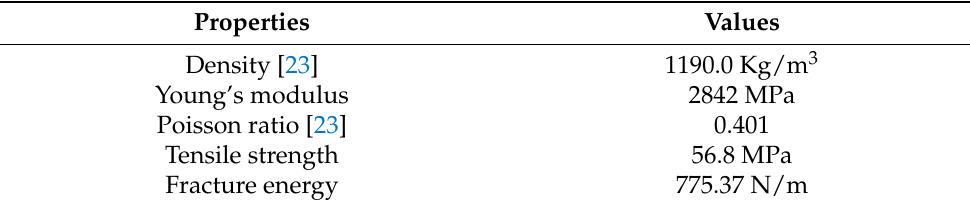
Table 2. Mechanical properties of polymethyl methacrylate